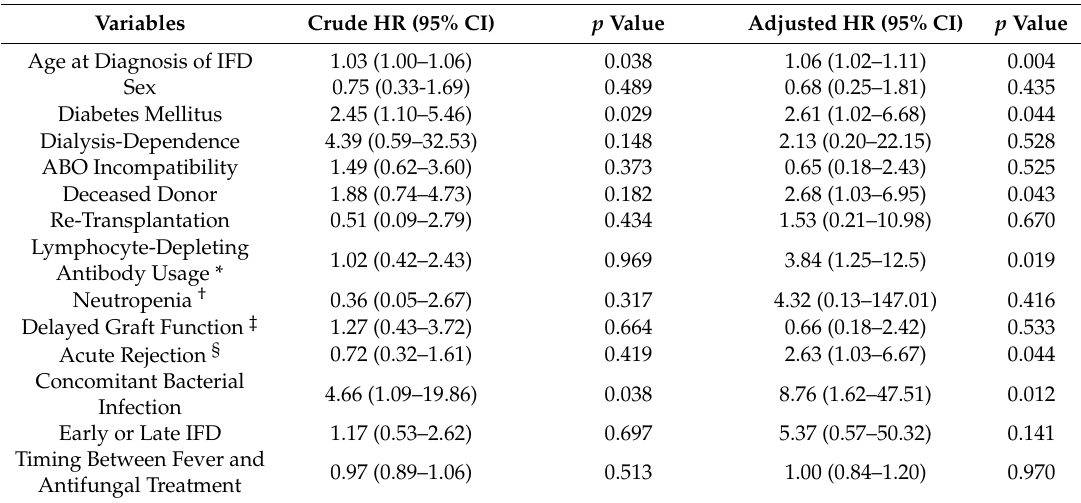
Table 4. Risk factors for 12-week mortality in all IFD patients after KT.